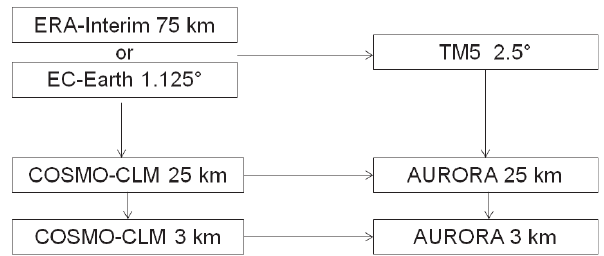
Figure 2: Overview of the 3 km model domain and the location of major cities (white squares) Figure 1. Schematic overview of the coupling between the atmo- and observation stations (white triangles). The location of station ‘Lanaken’ is indicated with spheric models used in this study and their horizontal resolutions. a red triangle.